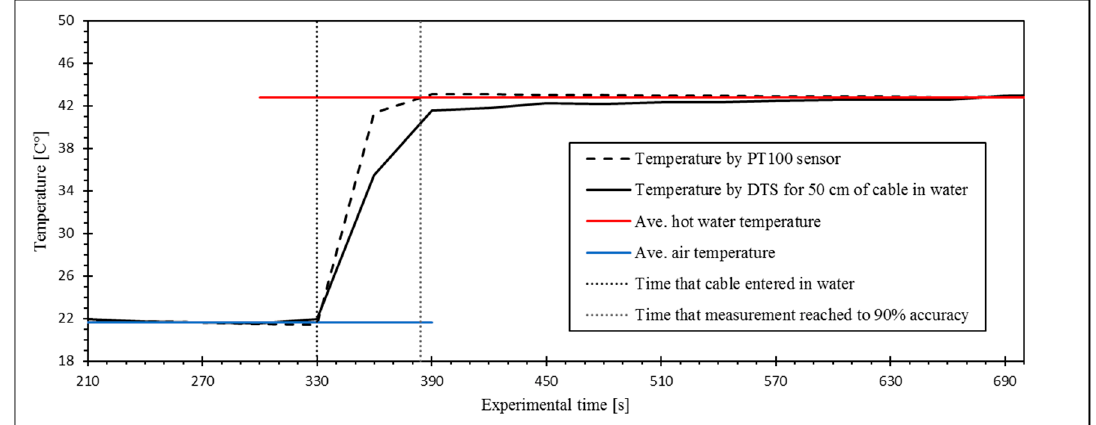
Figure 3. Response time of the system. The temperature measurement by the DTS reached to 90% of the temperature shift at the second reported temperature (60 s after cable entered in the hot water).